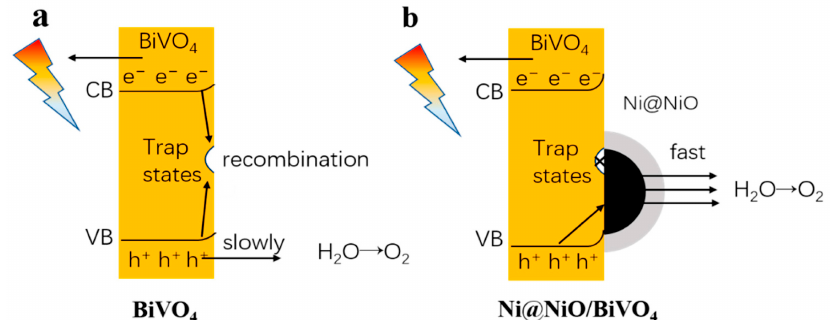
Figure 5. Photoelectrochemical water splitting mechanism of ( a ) BiVO 4 and ( b ) Ni@NiO/BiVO 4 photoanodes under